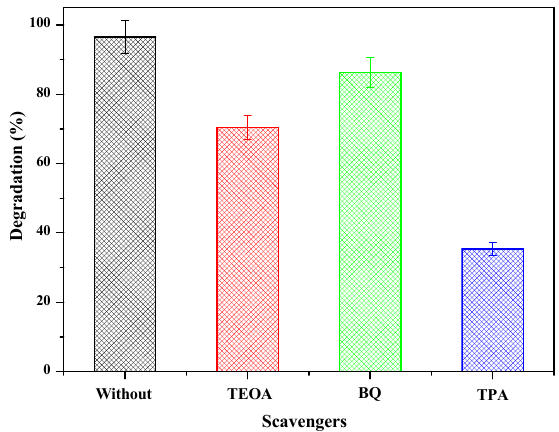
Figure 5. Trapping test of CeVO 4 -V 2 O 3 sample prepared with 10 mL EG.